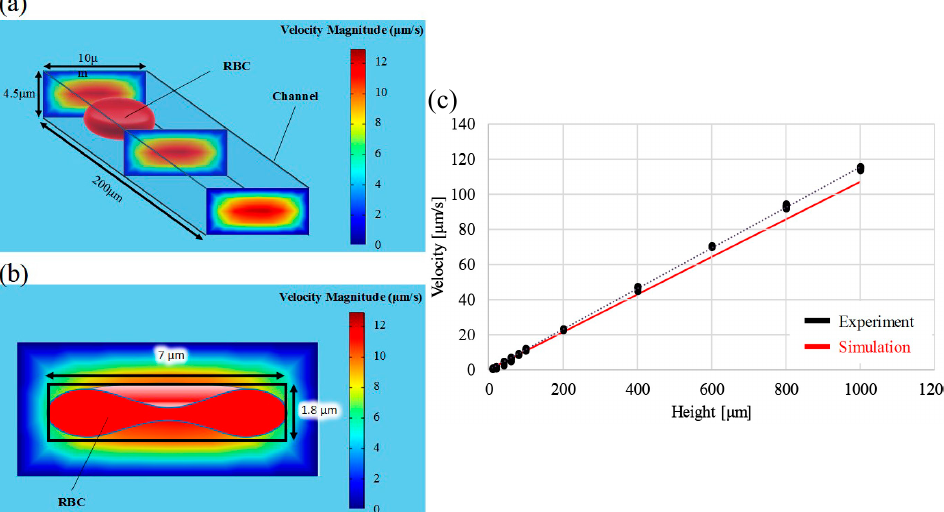
Figure 9. The comparison between theoretical and experimental results: ( a ) The simulated distribution of flow velocity in the microchannel from a 3-dimensional view; ( b ) The theoretical RBC velocity is estimated by the average flow velocity over the occupied area of the RBC in a cross-section; ( c ) Comparisons to the experimental results obtained with the water heads from ∆ H “ 10 µ m to ∆ H “ 1000 µ